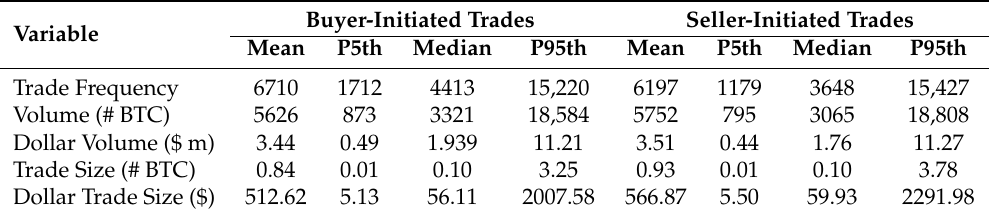
Table 2. Descriptive statistics of daily trading activity. The reported statistics are based on BTC-e transaction history data over the period from 7 December 2013 to 24 September 2014. Each day is defined to be from 0:00:00 to 23:59:59 ET.